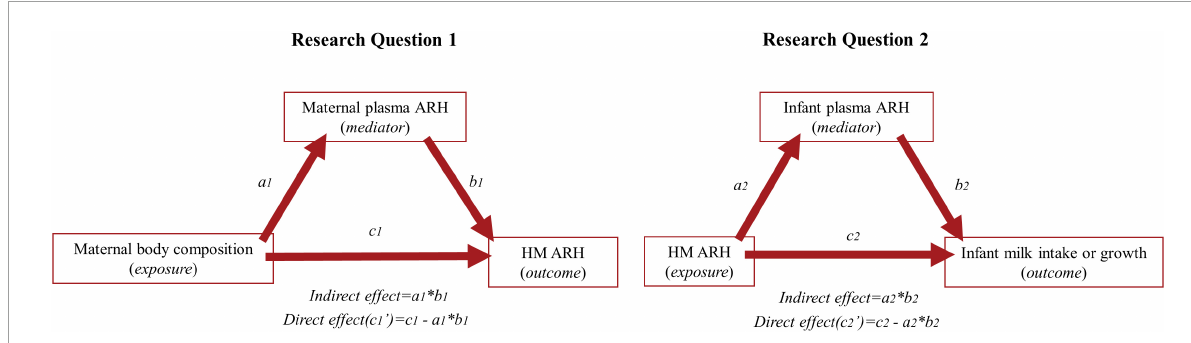
FIGURE1 Conceptual diagram of the investigated mediation analyses of Research Question (RQ) 1 (left) and 2 (right) . Maternal body composition (exposure) in RQ1 includes body mass index and fat mass index. Outcome in RQ1 and exposure in RQ2, HM ARH, includes human milk concentrations of leptin, insulin and adiponectin. Outcome in RQ2 includes infant milk intake (total 24-h milk intake and milk intake per feed), and infant growth (infant weight, length, fat mass index and body fat percentage). a 1 describes the estimate for the influence of exposure on mediator, b 1 indicates the estimate for the influence of the mediator on the outcome, and c 1 describes the total effect (direct + indirect) of exposure on outcome. The indirect effect (a 1 b 1 ) can be estimated by multiplying a 1 and b 1 and the direct effect can be estimated by